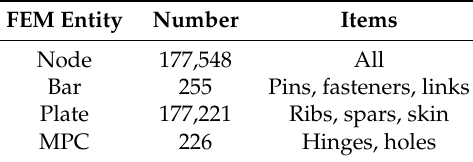
Table 3. Model data.